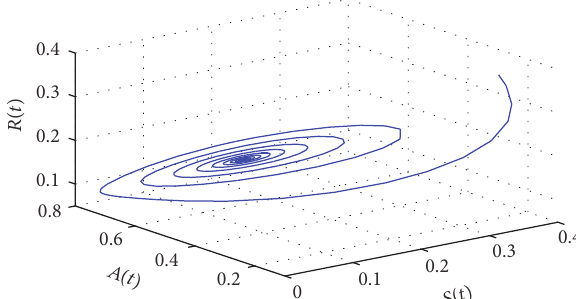
Figure 9: The phase plot of states 𝑆 ∗ , 𝐴 ∗ , and 𝑅 ∗ with 𝜏 = 21.35 < 24.2508 = 𝜏 0 .